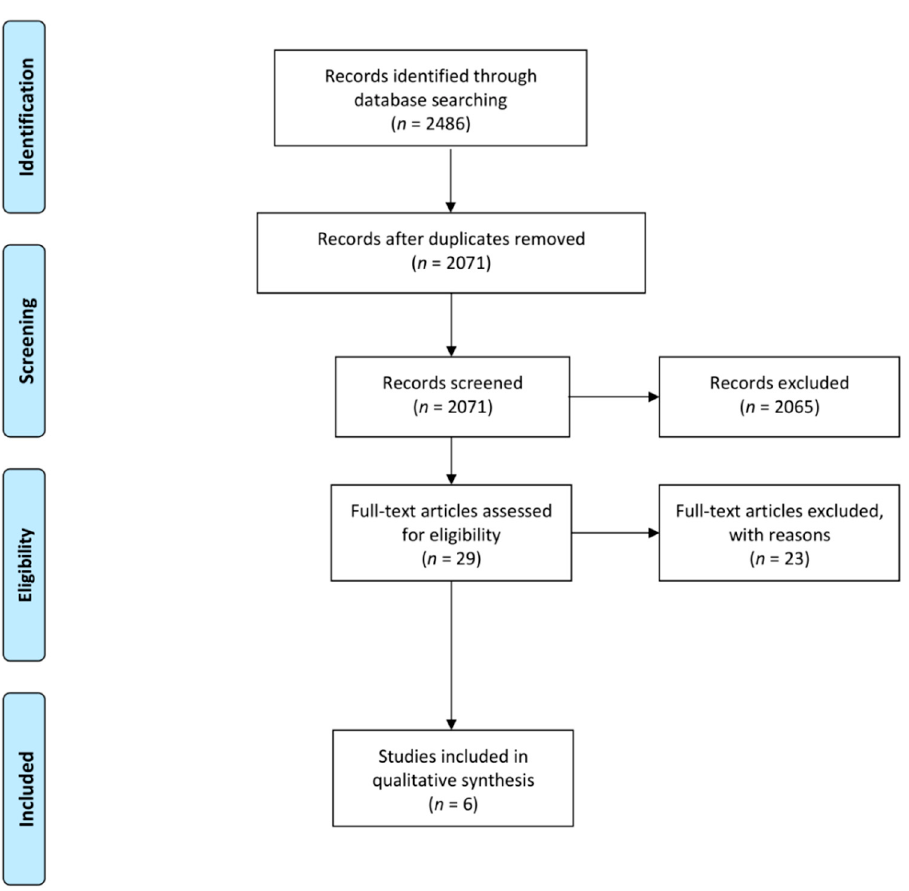
Figure 1. Preferred Reporting Items for Systematic Reviews and Meta-Analyses (PRISMA) flow diagram for results of search strategy.